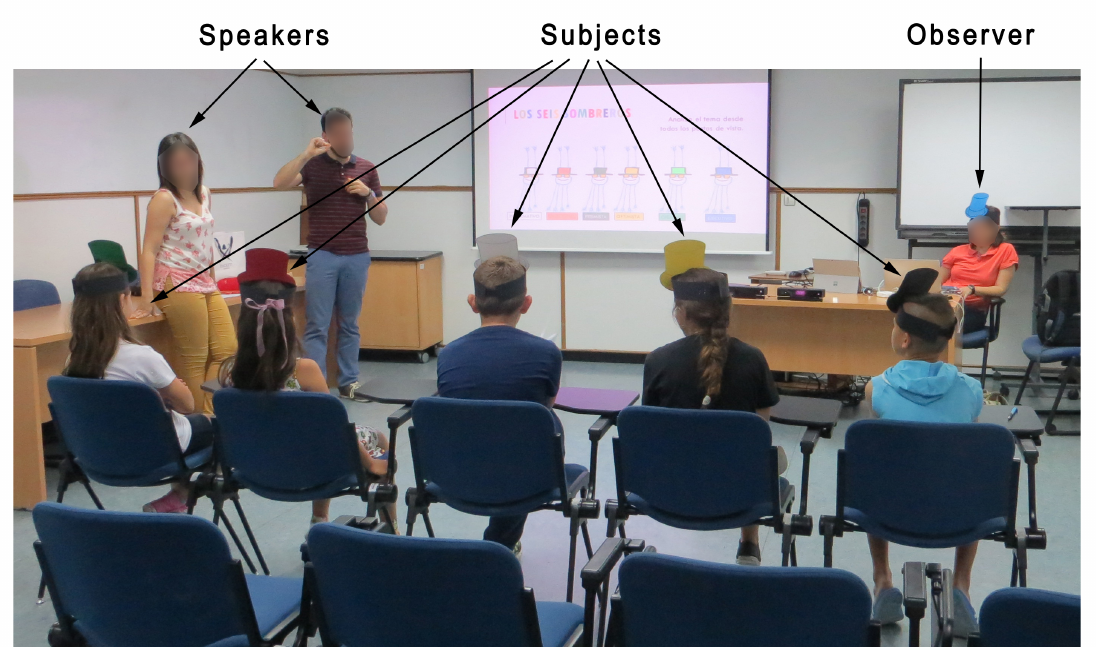
Figure 2. Classroom layout in the study techniques